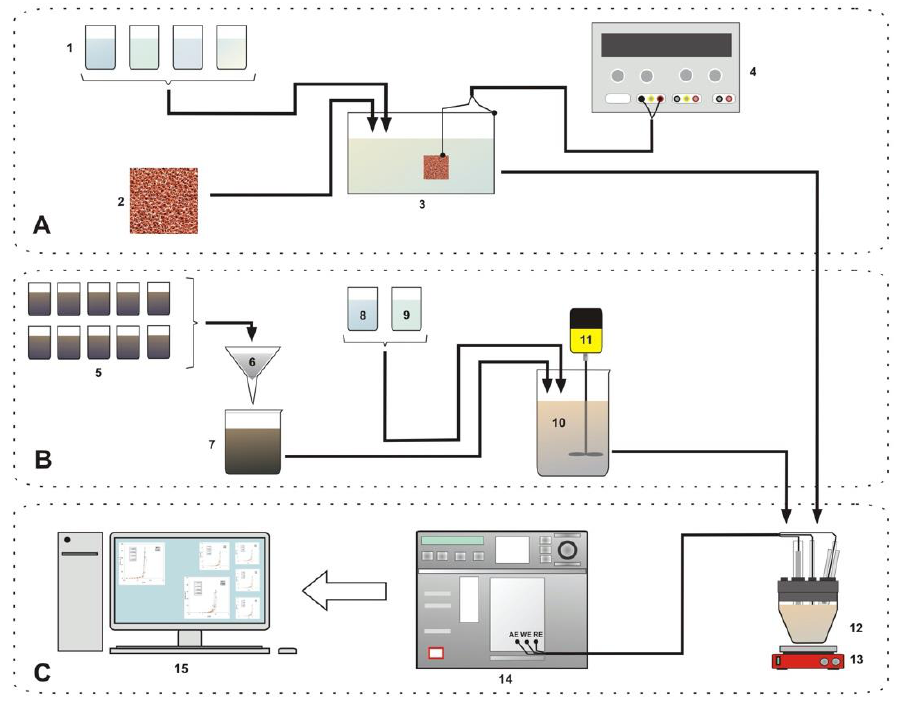
Figure 3. Measurement setup for WEO electrooxidation with new catalysts. ( A ) Electrochemical